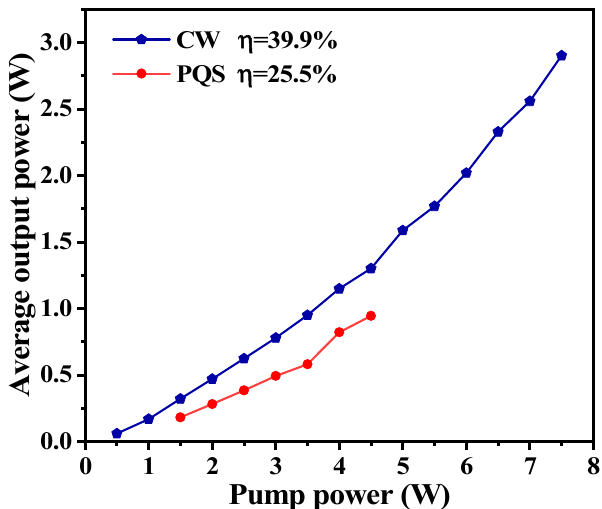
Figure 5. Output power versus pump power at CW (blue dots) and passively Q-switched (PQS) mode (red dots). By using a spectrometer (USB4000-VIS-NIR, Ocean Optics Inc., Dunedin, FL, USA) with a range of measurements from 200–1100 nm, the output spectra of CW and PQS Nd:YAG laser were achieved. As shown in Figure 6a, an output wavelength with a center wavelength of 1064.93 nm was acquired at the CW average output power of 1.3 W. While in the PQS mode, the output wavelengths with center wavelengths of 1064.93 nm, 1064.93 nm, 1065.17 nm, and 1065.41 nm were achieved with average output power increasing from 0.182 W to 0.946 W, which means the insertion of Ti 2 CT x -SAs rarely affected the central emission wavelength of the Nd:YAG laser. As shown in Figure 6b, the output spectrums of the laser at hourly intervals for five hours of PQS operation (output power: 0.946 W) was measured. And the results show slight changes in the PQS laser output spectrums.